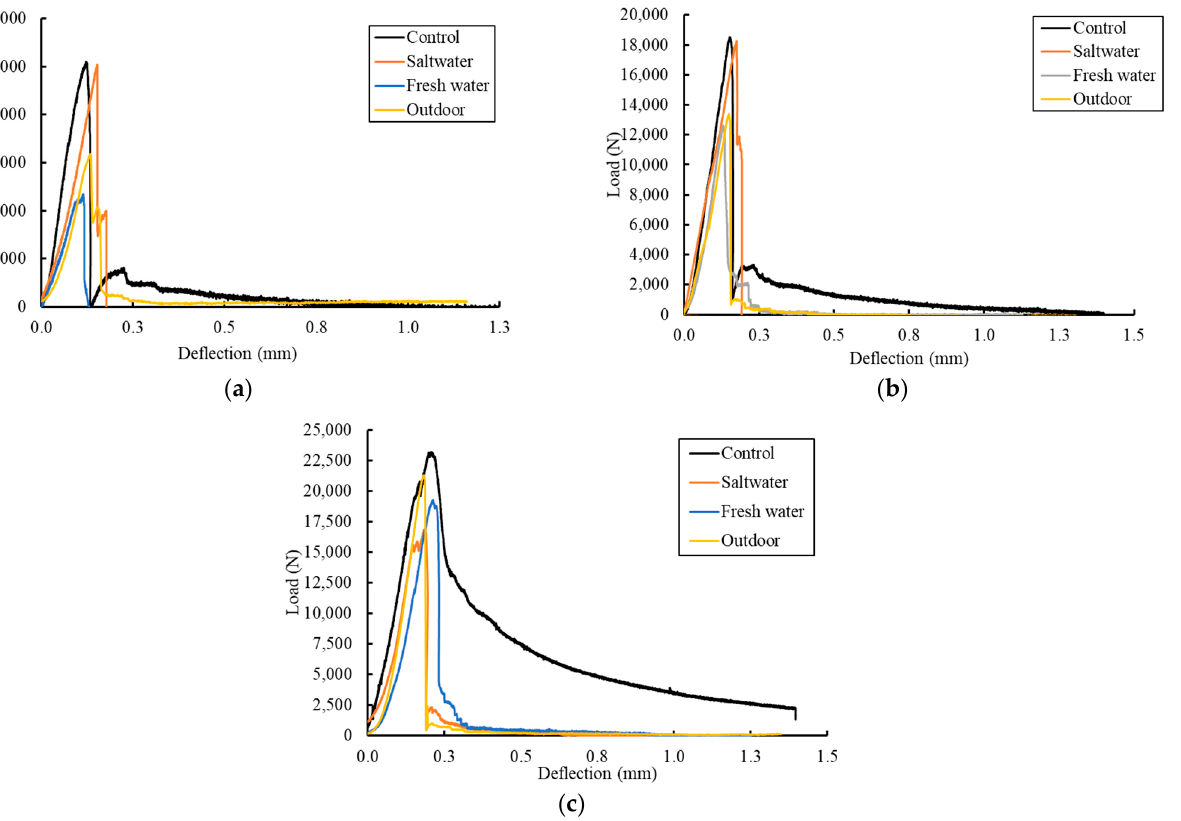
Figure 10. Load versus deflection curves after 195 days of exposure. ( a ) CFRP strip width of 25 mm (1.0 in.). ( b ) CFRP strip width of 50 mm (2.0 in.). ( c ) CFRP strip width of 75 mm (3.0 in.).